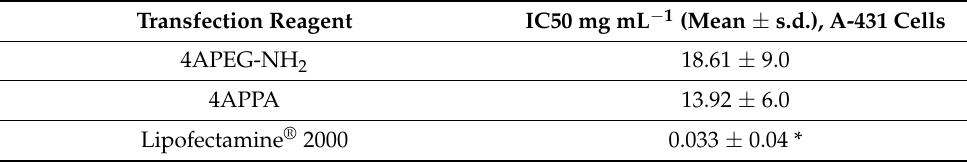
Table 1. In vitro cytotoxicity (IC50) in the A-431 cell line. Transfection